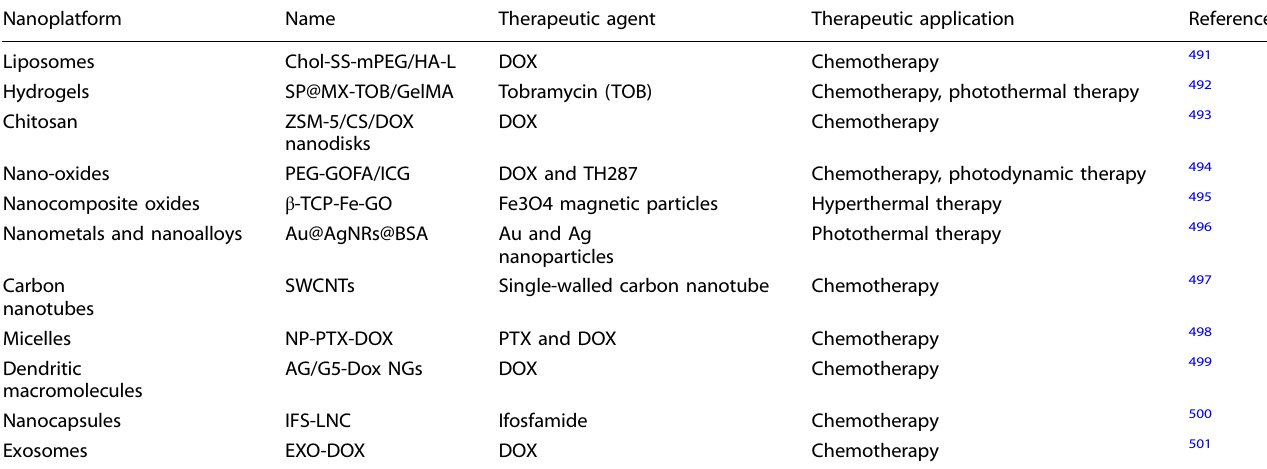
Table 5. Examples of different nanoparticles for osteosarcoma therapy